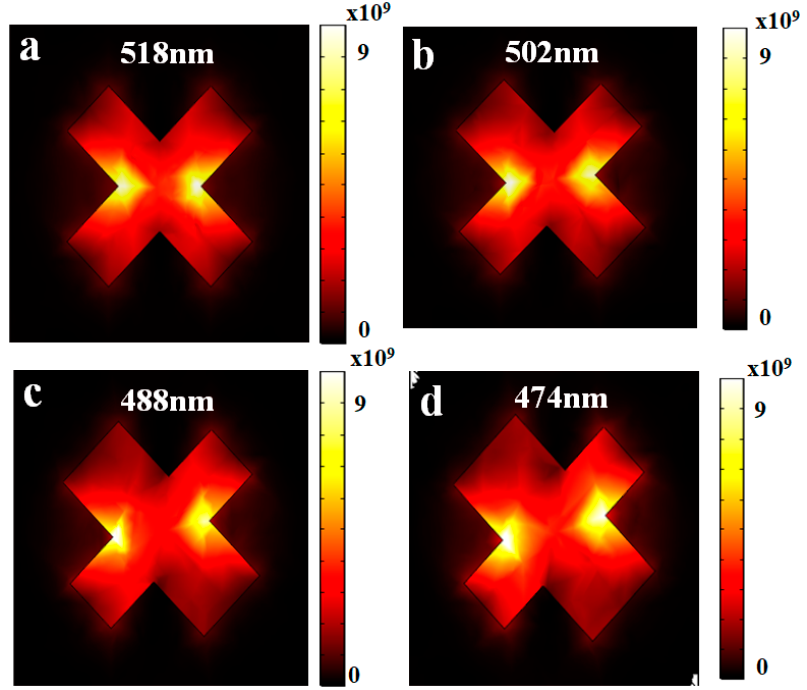
Figure 9. Electric field distribution at wavelengths 518 nm ( a ), 502 nm ( b ), 488 nm ( c ), and 474 nm ( d ) for defective structure d1.